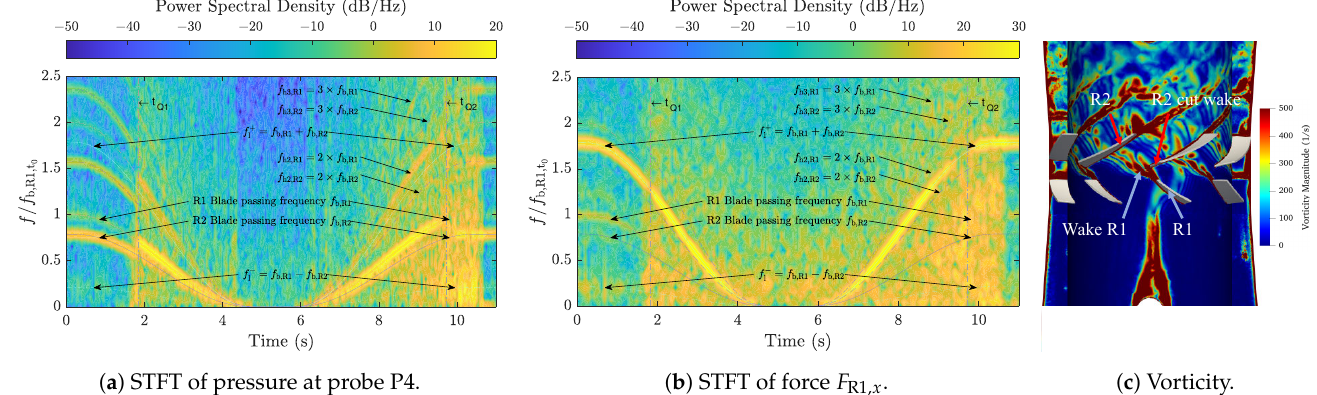
Figure 13. Spectrogram of the STFT and vorticity magnitude at the design point, during the transient sequences in pump mode. The frequency is normalised with f b,R1,t , the blade passing frequency of Runner 1 at t 0 . Indices R1 and R2 denote 0 Runner 1 and 2, respectively; b denotes the blade passing frequency; h2 is the second harmonic; h3 is the third harmonic; l is a linear combination. The vorticity is captured at the design point on a meridional plane and a cylinder (midpoint radius between hub and shroud) cutting the domain, close to the